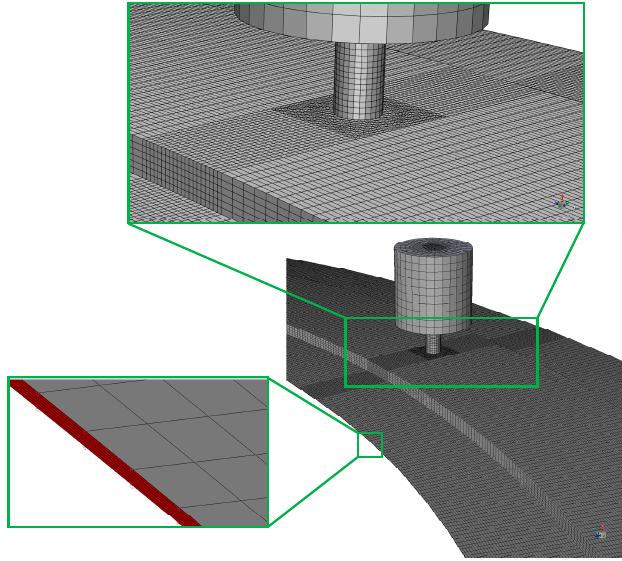
Figure 3. Partial computational meshes .